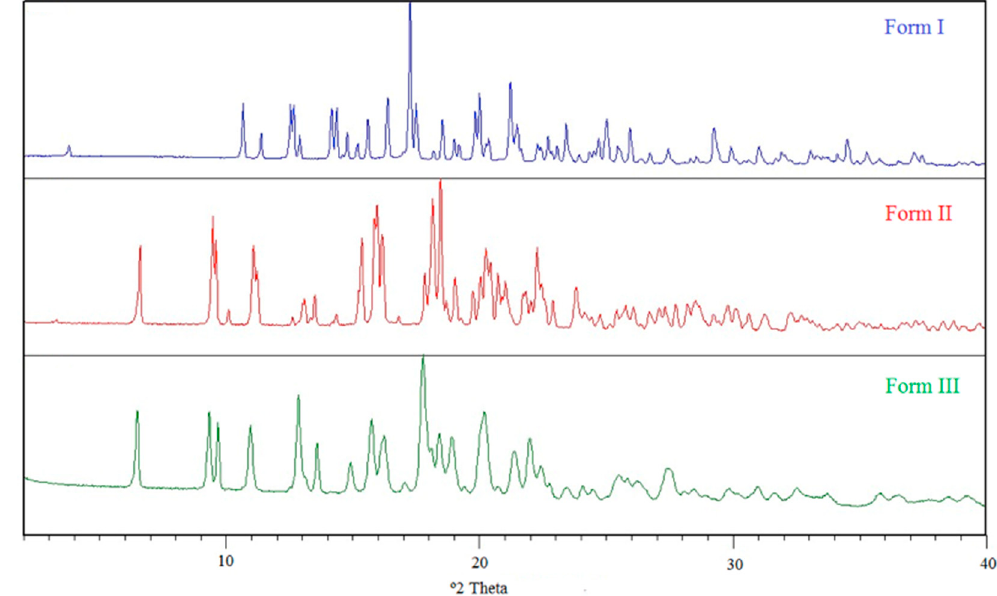
Figure 3. PXRD patterns of the different anhydrous forms of BL.